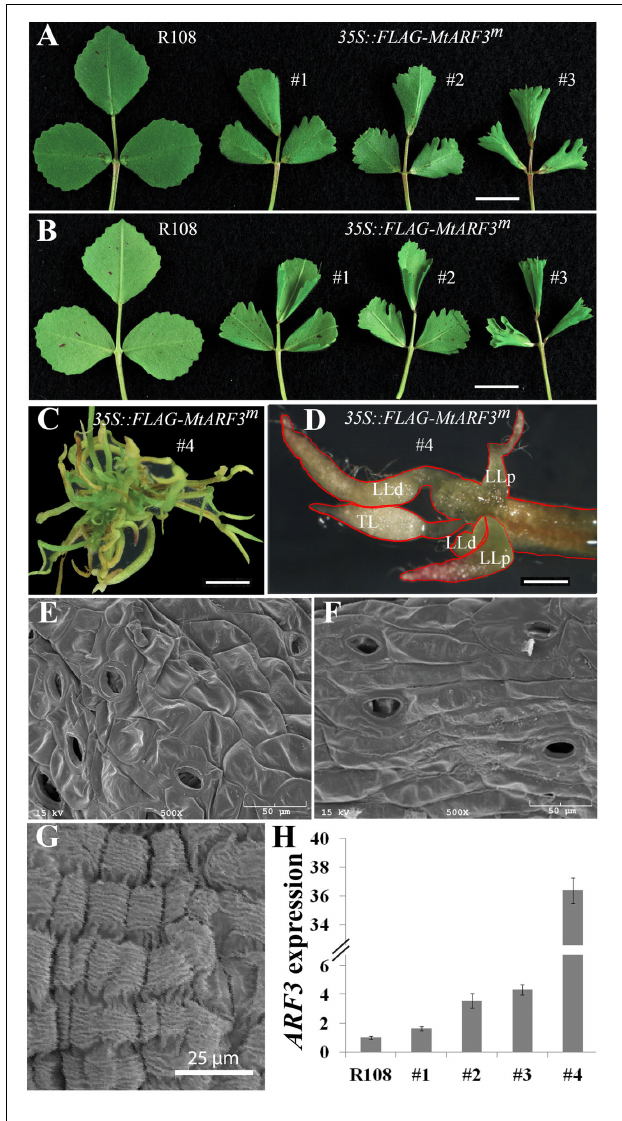
FIGURE 4 | Overexpression of MtARF3 m leads to altered compound leaf patterning in M. truncatula . Adaxial (A) and abaxial (B) views of compound leaves in wild type (R108) and three independent transgenic lines that overexpress MtARF3 m (35S:: FLAG-MtARF3 m ). Leaflets exhibited deep serration and curling at the distal and proximal margins, respectively, in transgenic plants compared with wild type. (C,D) Severe compound leaf phenotypes of a strong MtARF3 m overexpressor. The transgenic plant exhibited pentafoliate leaves with needle-like blades (outlined in red). LLp, proximal lateral leaflets; LLd, distal lateral leaflets; TL, terminal leaflet. (E,F) SEM images of the adaxial (E) and abaxial (F) surface epidermal cells of TL (D) . (G) A SEM image of epidermal cells of LLd (D) . (H) Quantitative RT-PCR analysis of MtARF3 expression in young leaf tissues in MtARF3 m overexpression lines. Shown are means ± SD; n = 3. Scale bars: 1 cm (A,B) ; 2 mm (C,D)